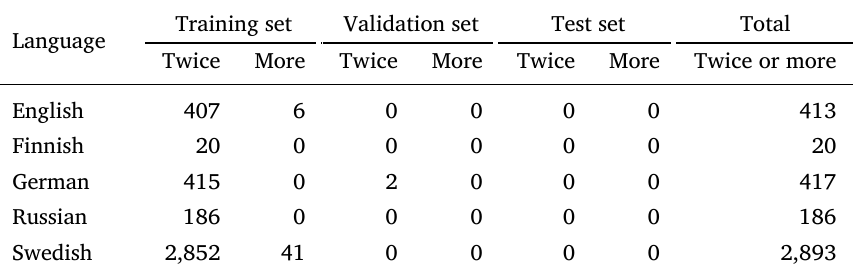
Table 3: Number of ambiguities detected in the data. This is the number of words that occur twice or more as a source word or as a target word in respective dataset